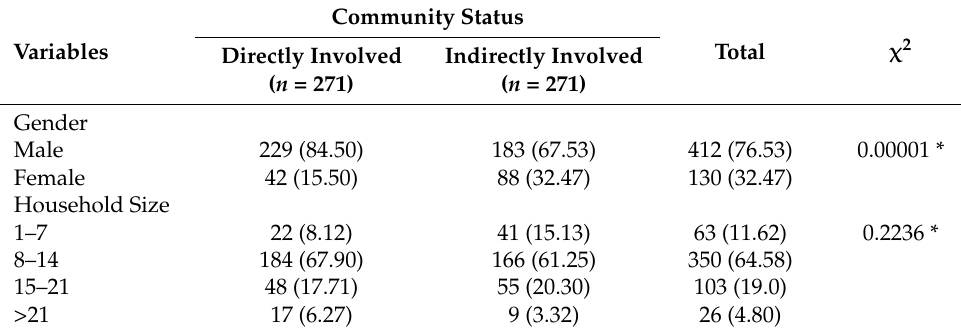
Table 6. Gender distribution and household size of the